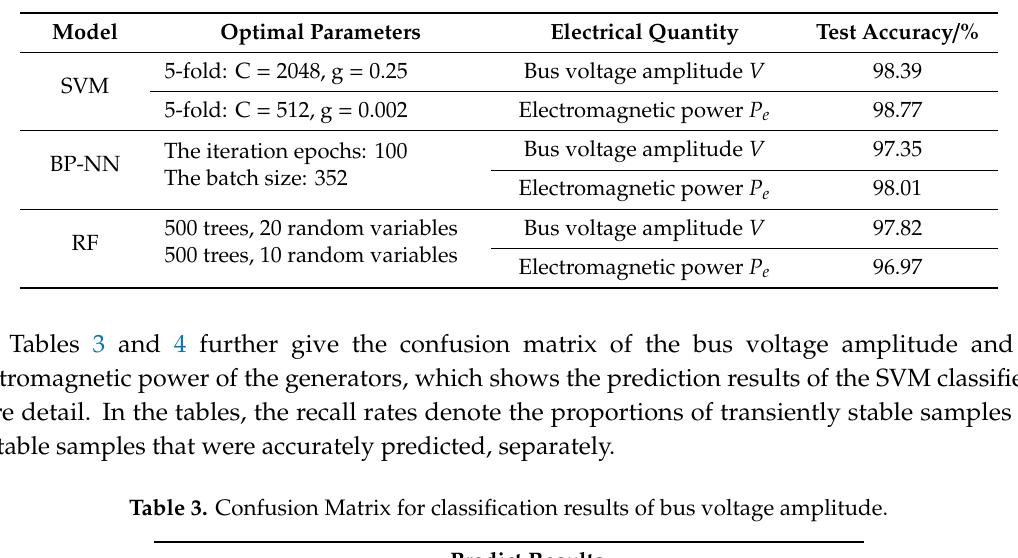
Table 2. Confusion Matrix for classification results of electromagnetic power.